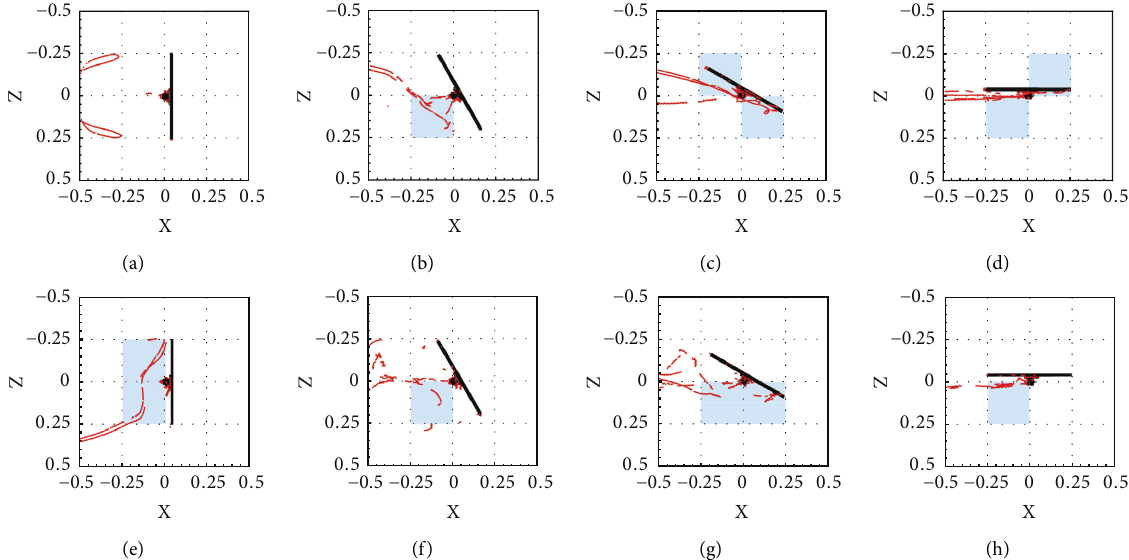
Figure 15: Vortex cores track at four instantaneous positions for the solid plate antenna. The wind is blowing from right to left. (a)–(d) Stationary and (e)–(h) azimuthal rotation. (a) β � 0 ° , (b) β � 30 ° , (c) β � 60 ° , (d) β � 90 ° , (e) β � 0 ° , (f) β � 30 ° , (g) β � 60 ° , and (h) β � 90 °